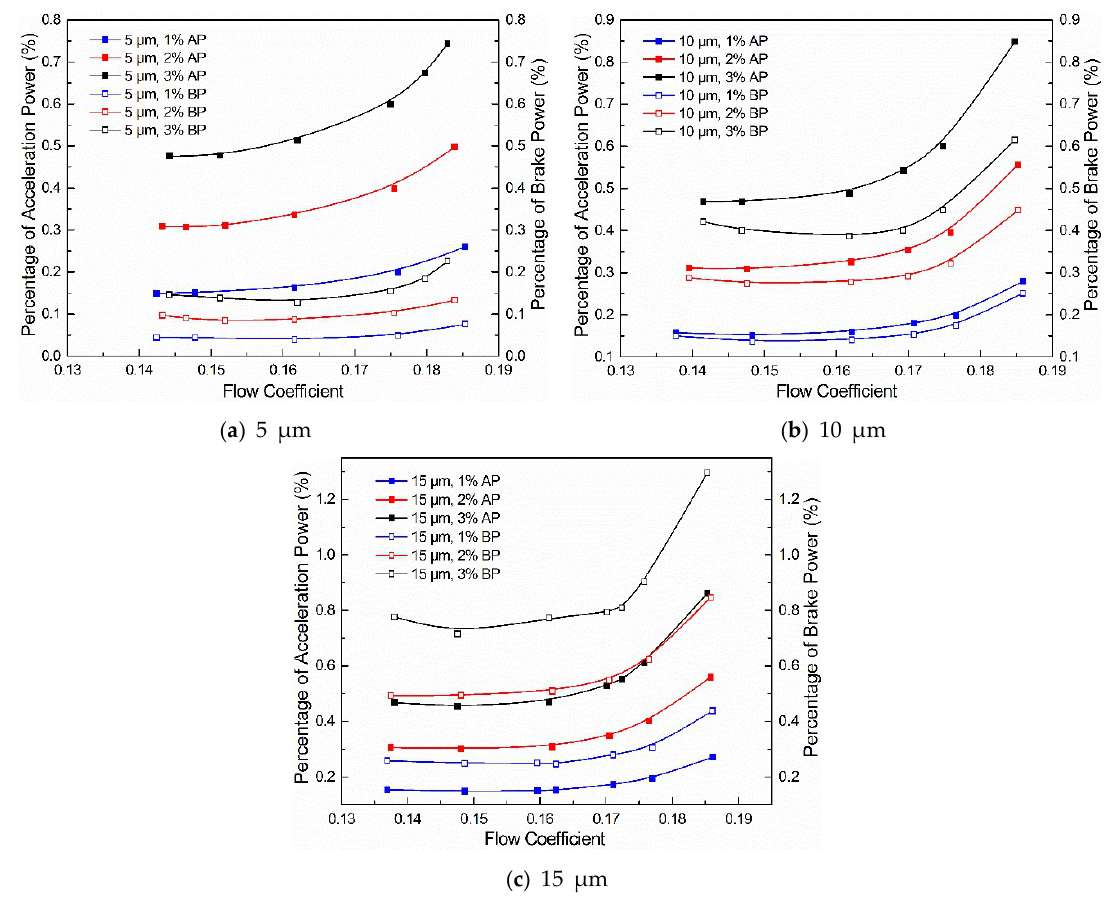
Figure 10. Percentages of acceleration and brake power